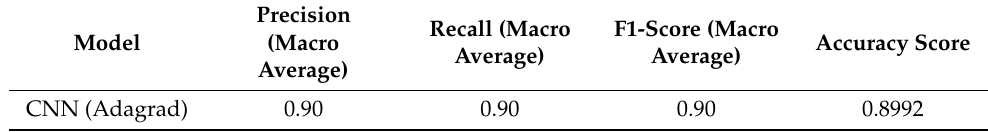
Table 8. Standalone deep-learning models trained on the MNIST Arabic digit dataset.